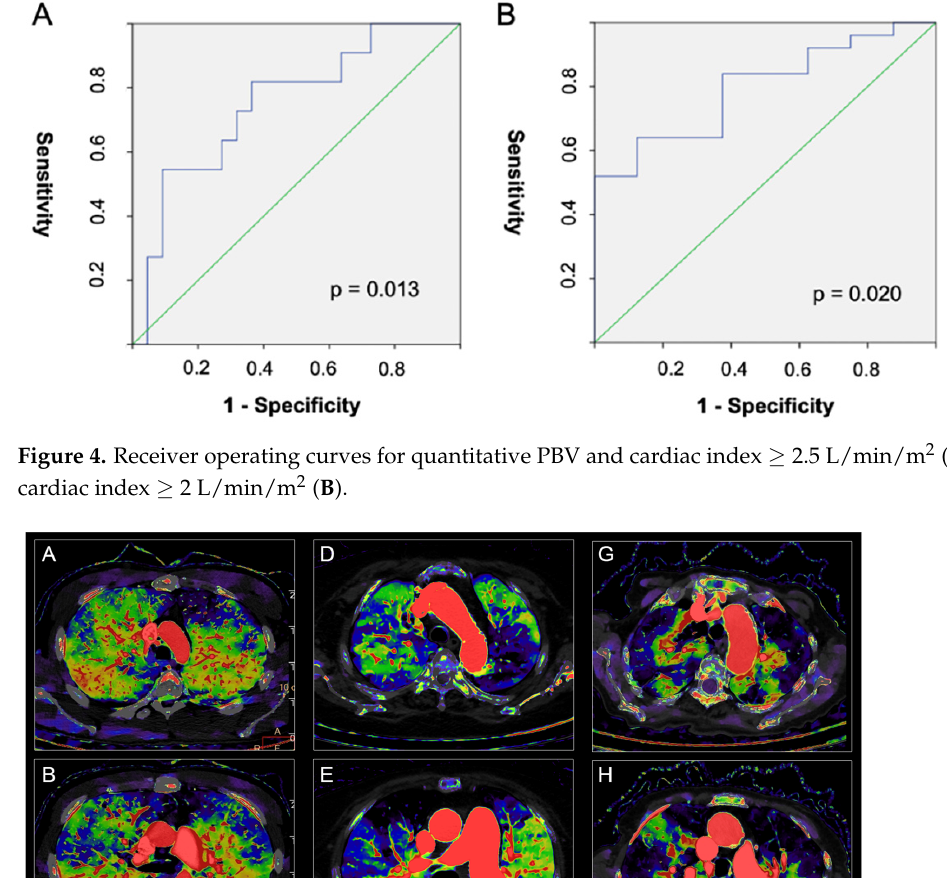
Figure 3. Correlation graphs between quantitative perfusion blood volume (PBV) and hemodynam-